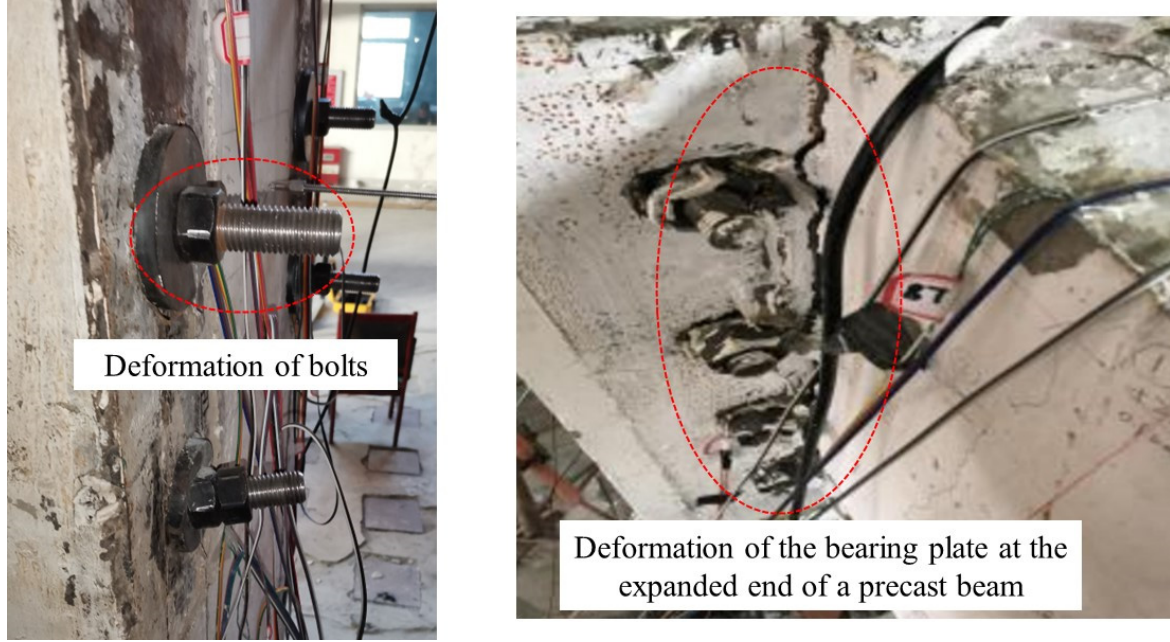
Figure 13. View of bearing plate and bolt damage.